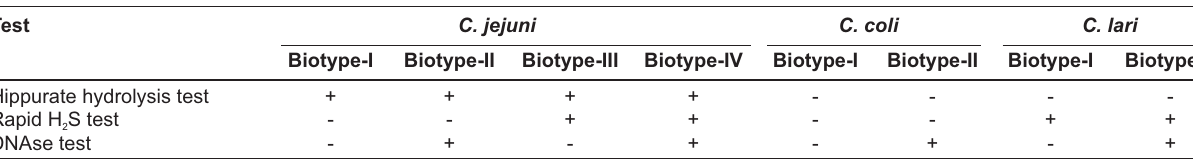
Table-1: Biotyping scheme of